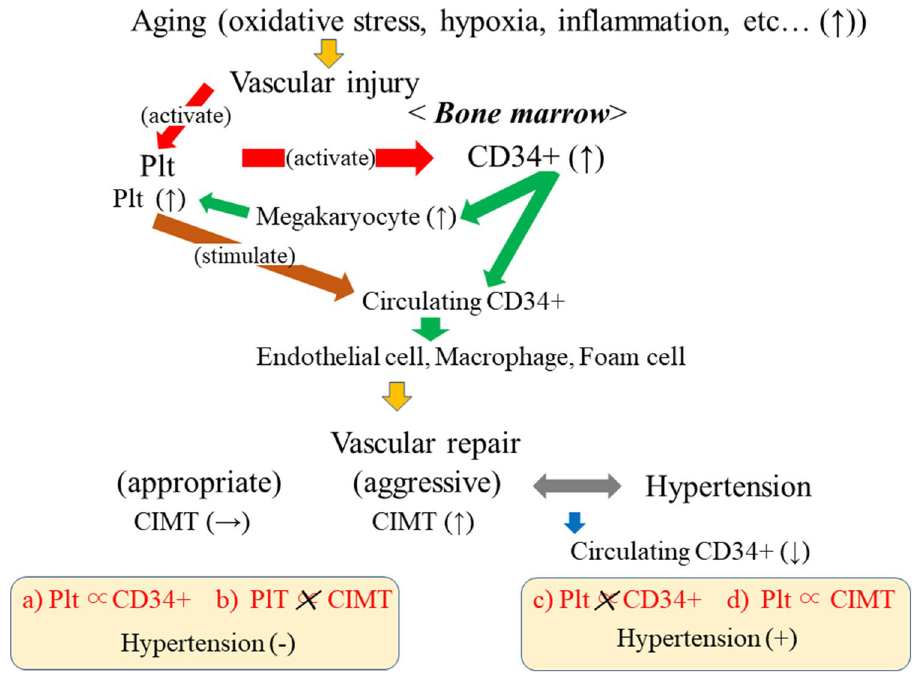
Figure 1. Platelet, circulating CD34-positive cell, and hypertension 22 . Associations shown in red (a–d) were observed in previous study. Associations (a,b) were observed among non-hypertensive men and (c,d) were observed among hypertensive men. CD34 + CD34-positive cell, CIMT carotid intima-media thickness, Plt platelet.